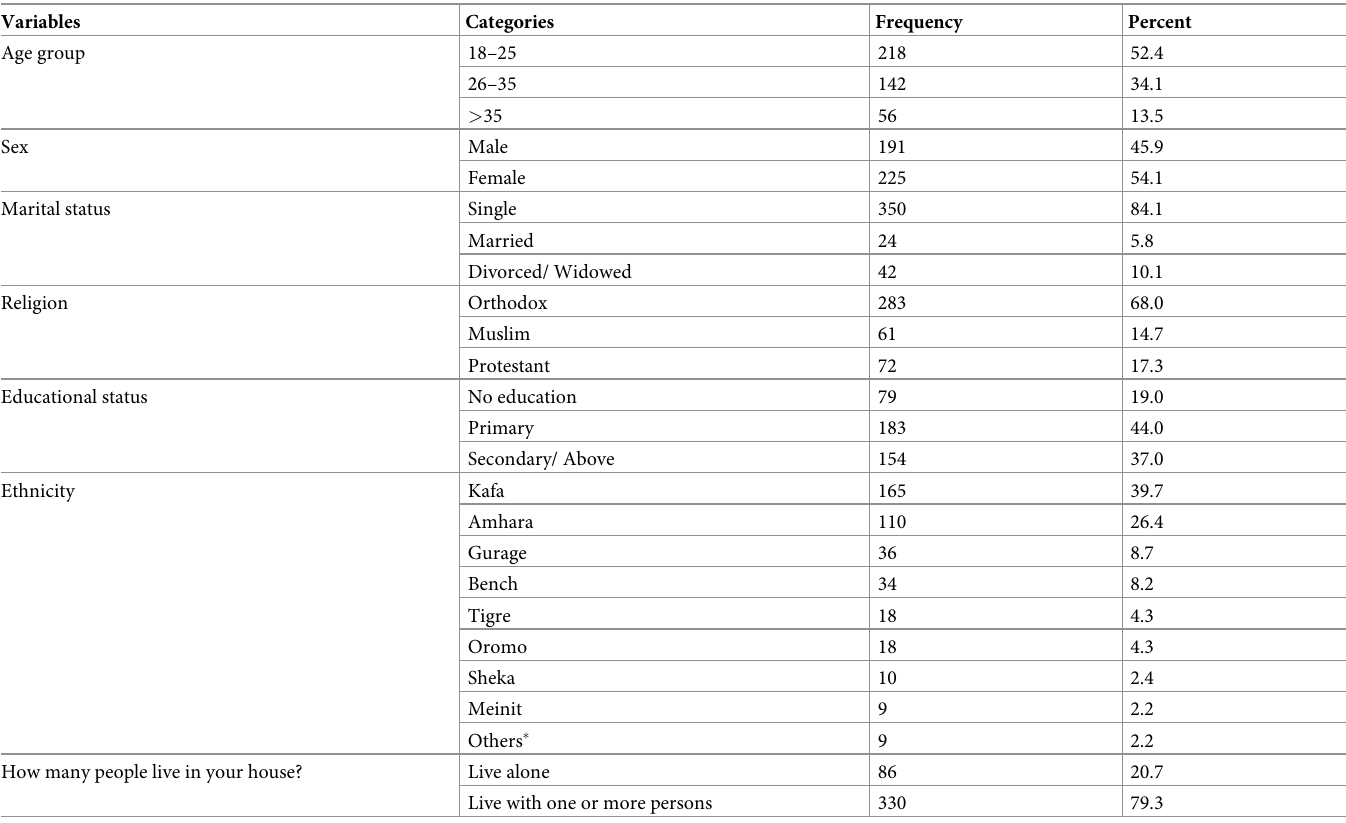
Table 1. Socio-demographic characteristics of waiters working in food and drinking establishments, Southwest Ethiopia,